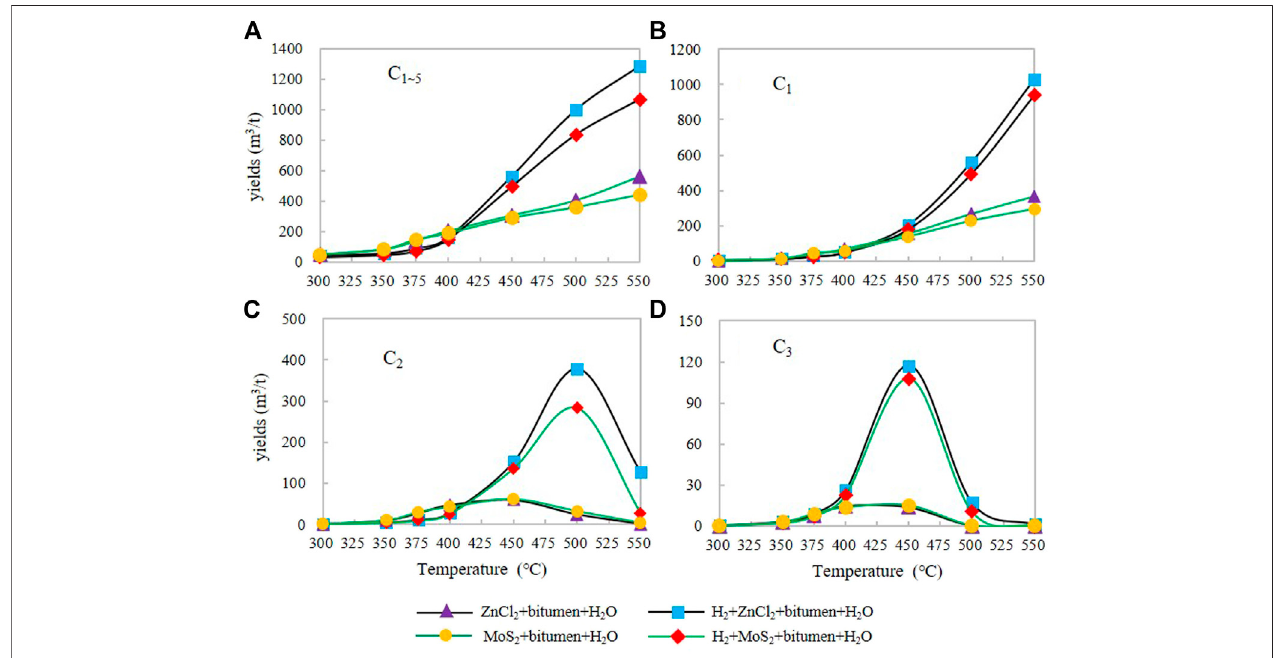
FIGURE 1 | The yield characteristics of C 1~5 (A) , C 1 (B) , C 2 (C) , C 3 (D) under different catalytic hydrogenation control conditions of the closed system.